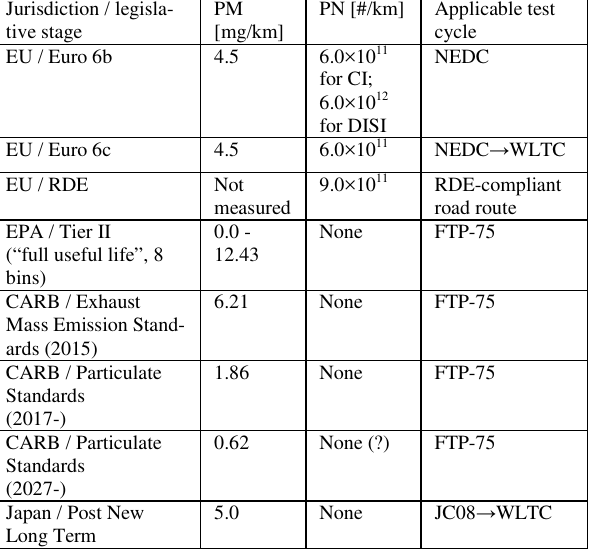
Table 1. A summary of particulate emissions control strategies in selected automotive markets Jurisdiction / legisla- tive stage